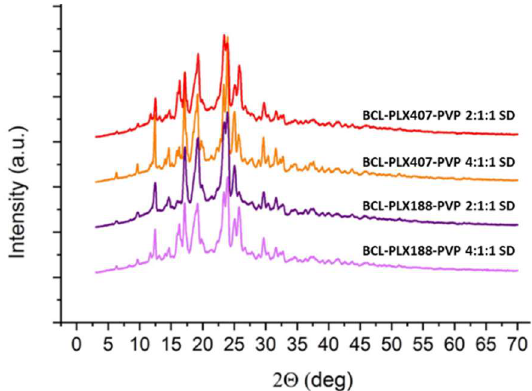
Figure 5. X-ray diffraction patterns of ternary systems containing bicalutamide, PVP, and either PLX 188 or PLX 407 obtained by spray drying.